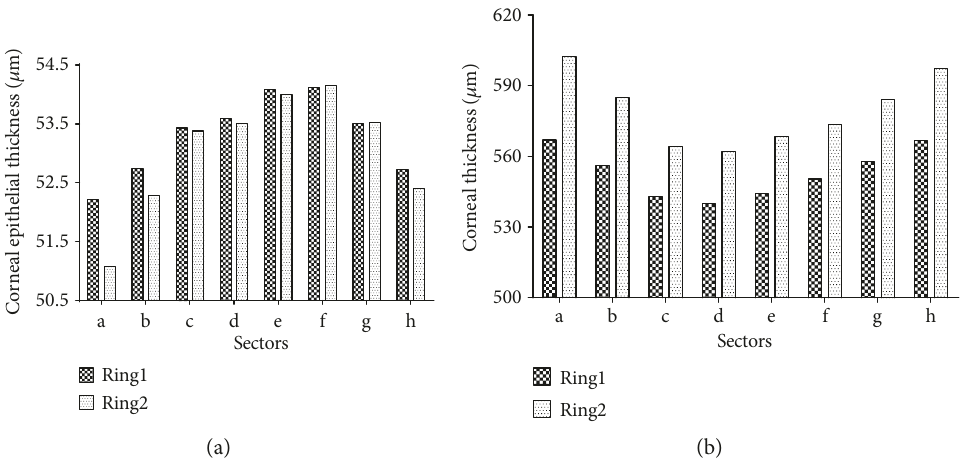
Figure 3: The detailed corneal epithelial thickness (a) and corneal thickness (b) of di ff erent sectors in Ring1 and